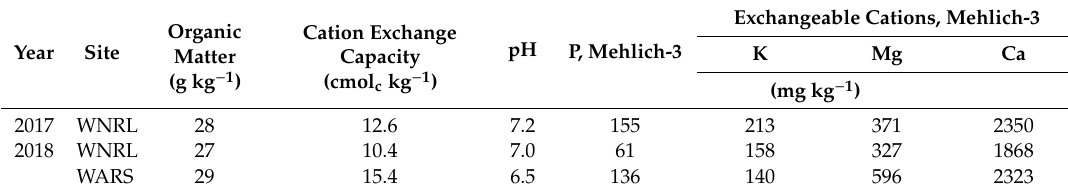
Table 7. Soil sample analysis for the Waterman Agricultural and Natural Resource Laboratory (WNRL) in 2017 and 2018, and the Western Agricultural Research Station (WARS) in